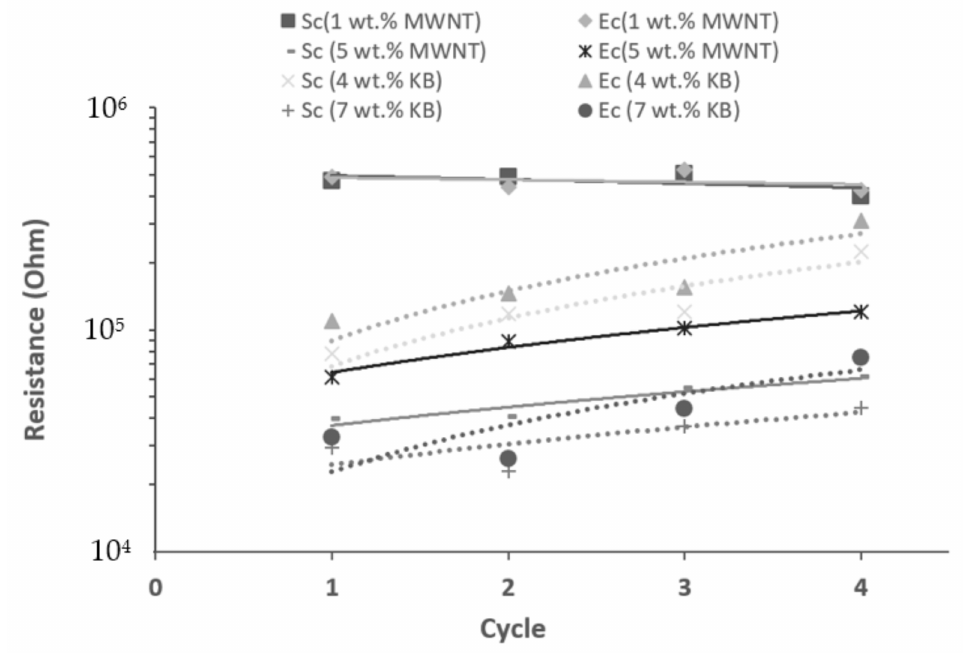
Figure 5. Resistance changes at the start and end of each cycle for different samples (Sc is the start of the cycle and Ec is the end of the cycle. The solid and dot linear trend lines represented MWNT and KB composites,